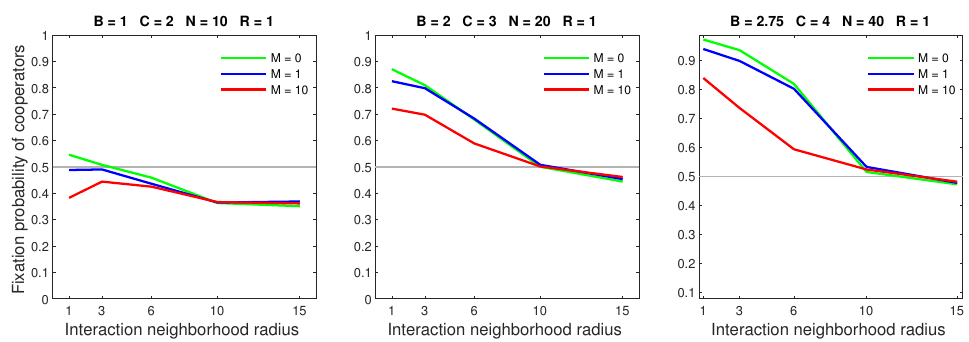
Figure 7. In the probabilistic dispersal model, increasing the mobility rate can greatly diminish the advantage of cooperators in dense populations.